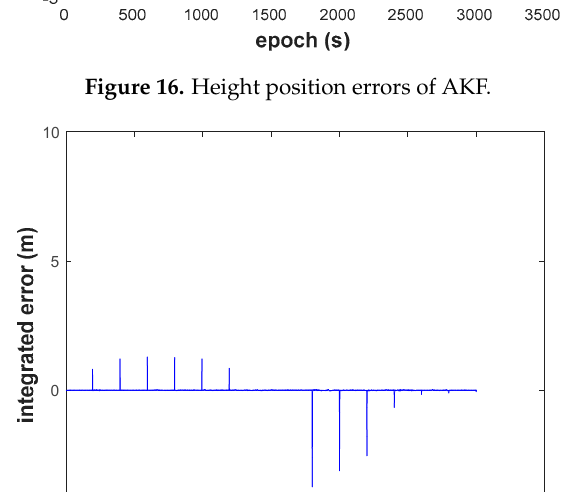
Figure 17. Height position errors of ARKF.